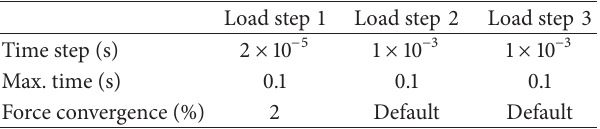
Table 5: Summary of load steps introduced in the FEA